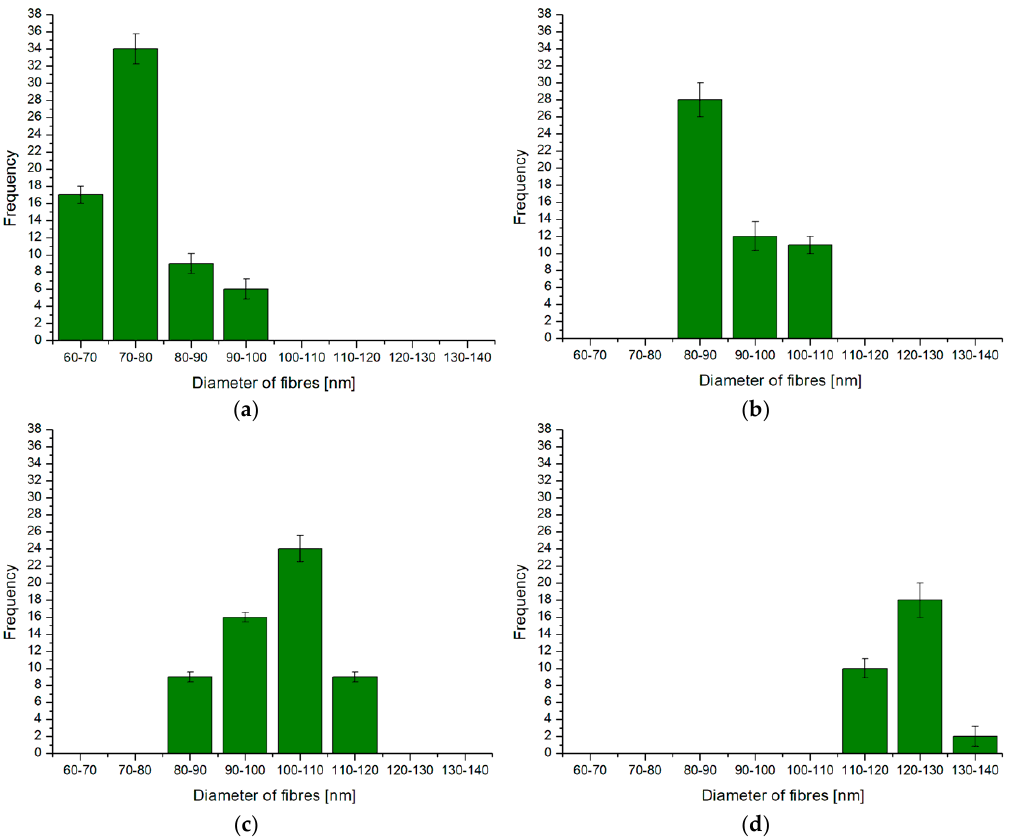
Figure 3. Histograms of nanofibers: ( a ) Sample A, ( b ) Sample B, ( c ) Sample C, ( d ) Sample D (sample designations in Table 2).